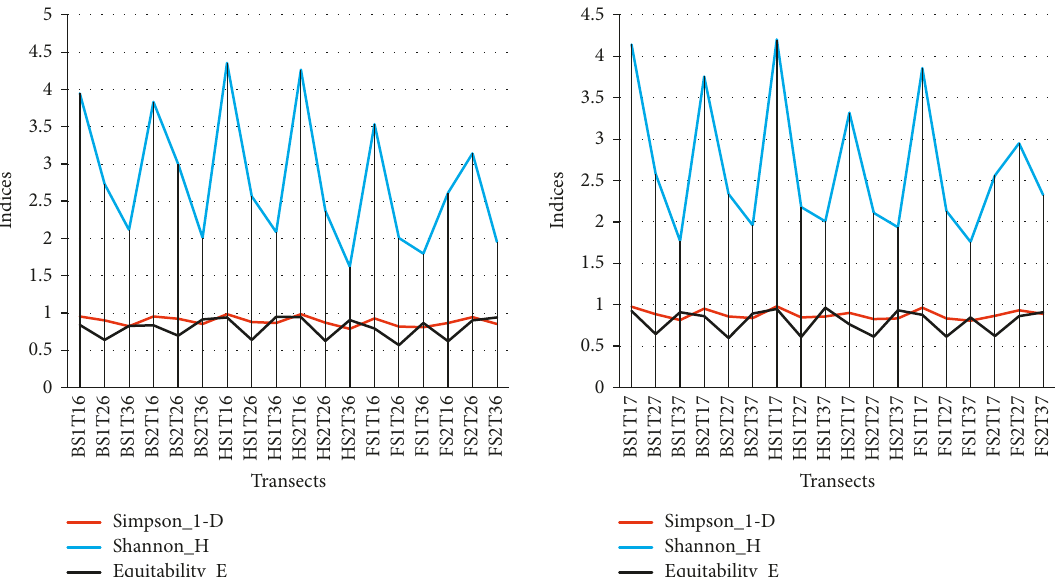
Figure 7: Diversity and dominance of insects in the studied transects in all sites of three saline wetlands during the study period (2016-2017).